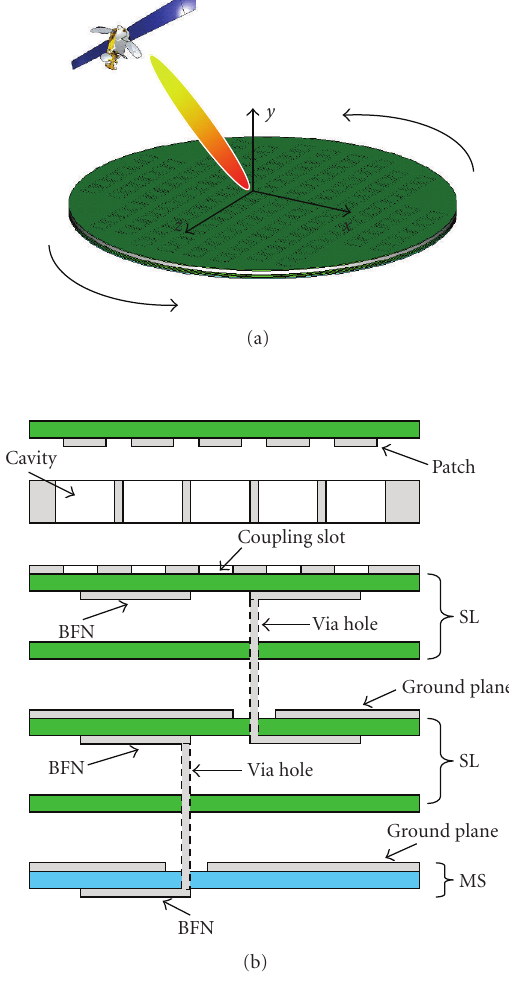
Figure 7: Antenna Architecture. BFN realized with two strip- line layers and a microstrip layer. Beam scanning is electronic in elevation and mechanical in azimuth.